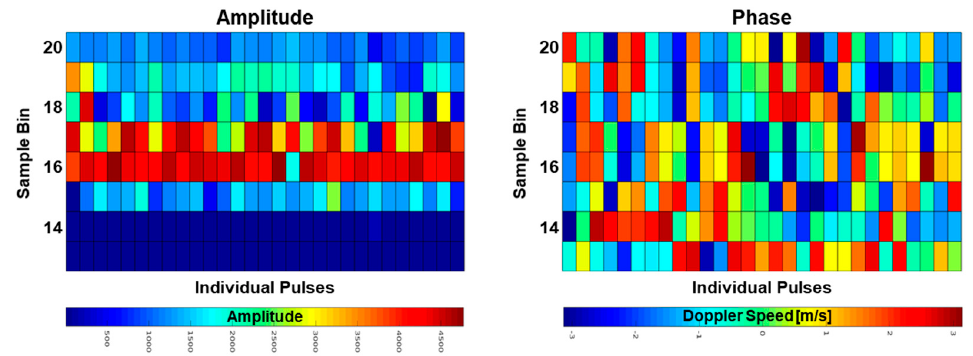
Figure 4. Amplitude ( left ) and phase ( right ) retrieved from the digitized signal. The amplitude is highest where the main energy of the pulse is sampled by the ADC, in this case at bin 16.